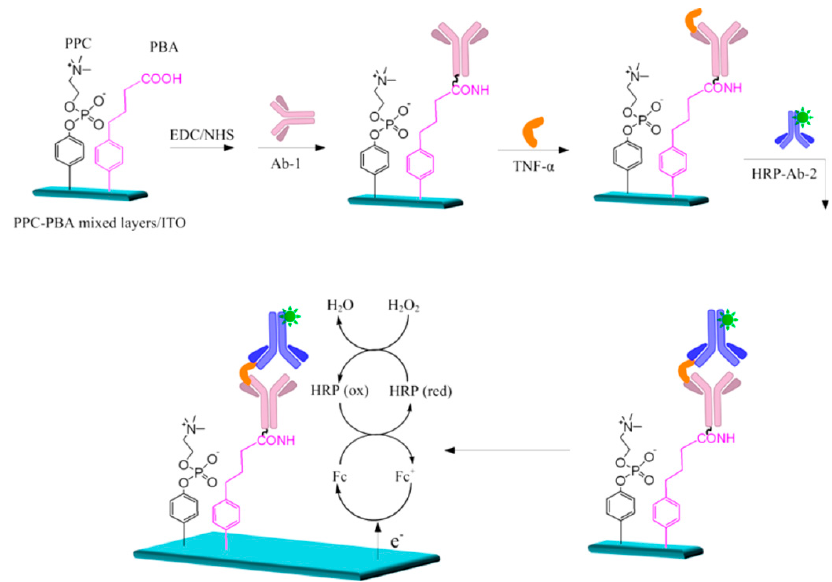
Figure 19. Immunoassay of tumor necrosis factor α (TNF- α ) factor based on a mixed antifouling platform. From Reference [117] with permission of the American Chemical Society.